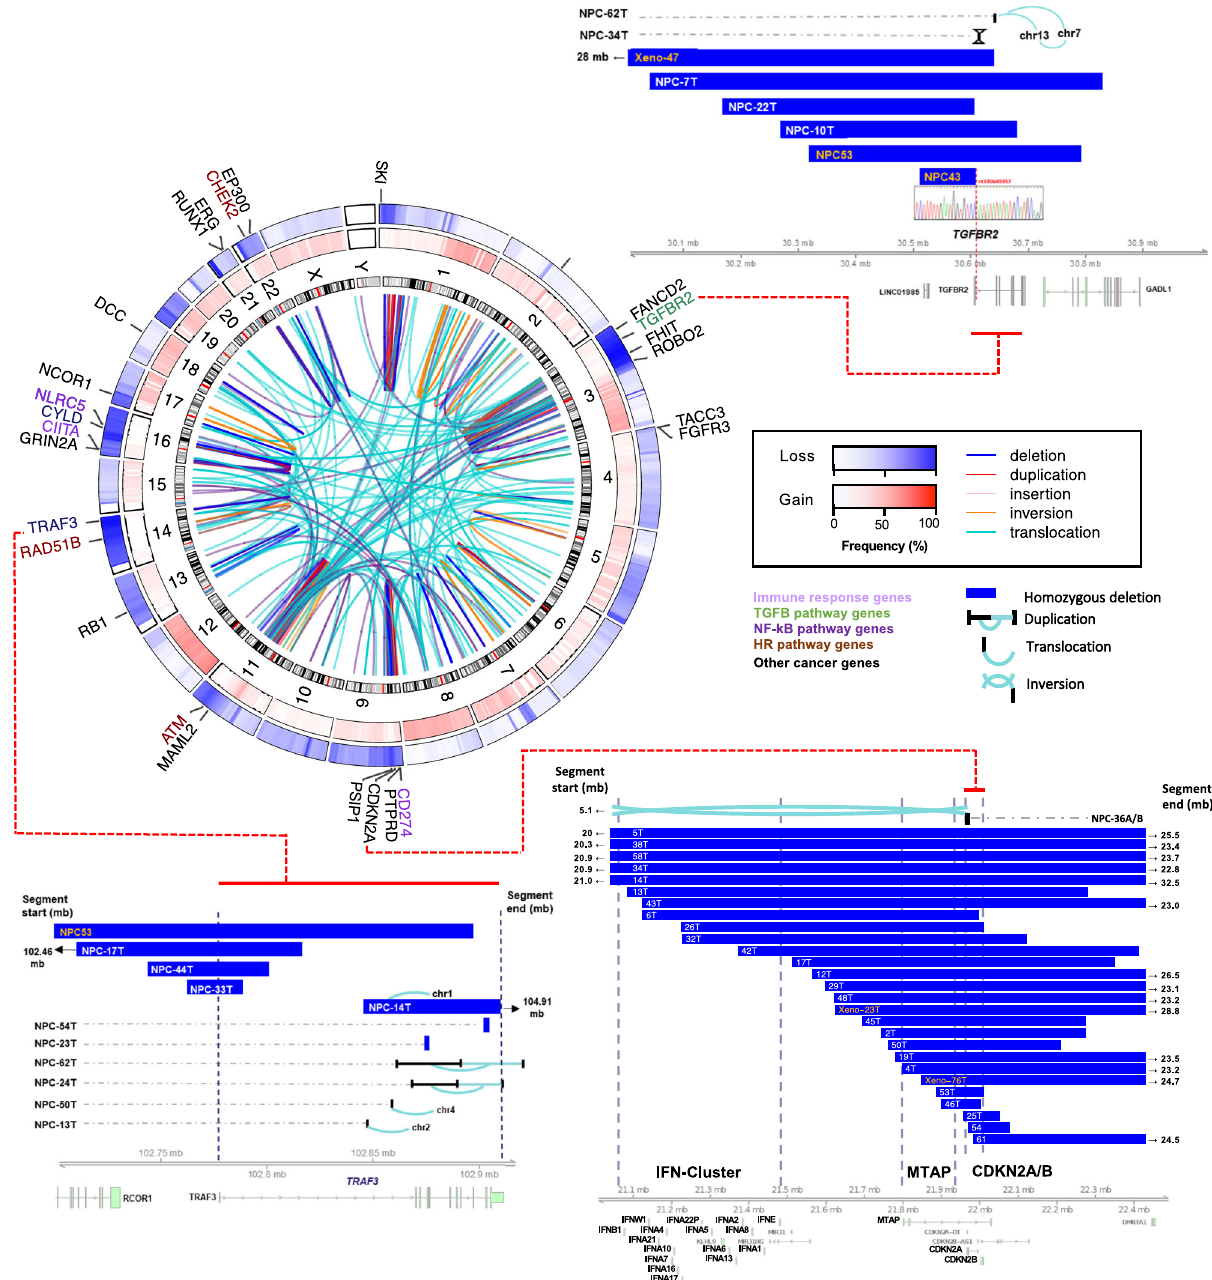
Fig. 2 Recurrent structural and chromosomal alterations in NPC. Circos plot showing recurrent SVs and common CNVs in NPC. Frequencies of copy number losses and gains are shown in the outer and inner circles respectively. Selected cancer genes involved in the recurrent inter- and intra- chromosomal SVs (i.e., genes with ≥ 3 times altered by SVs) are indicated. Homozygous deletions and structural alteration breakpoints identi fi ed in CDKN2A/B loci, MTAP , and cluster of type I IFN genes at 9p13.3, TGFBR2 at 3p24.1, and TRAF3 at 14q32.3 are shown. The DNA sequences spanning the breakpoints of deletion of TGFBR2 identi fi ed in NPC43 and Xeno-47 were con fi rmed by Sanger DNA